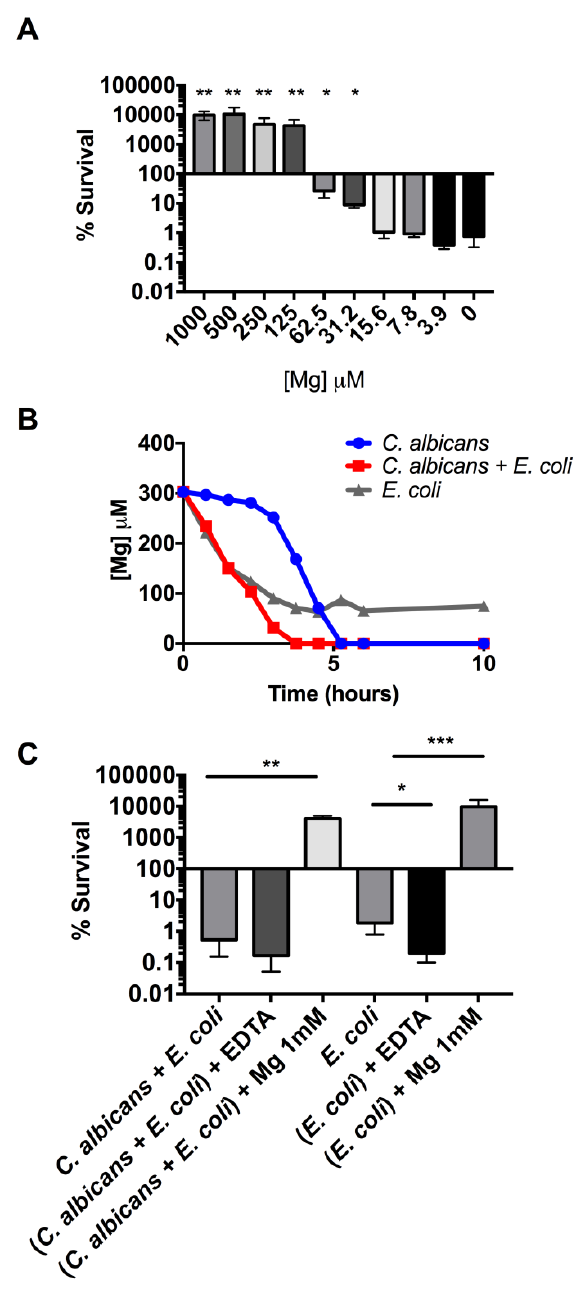
FIGURE 3: E. coli toxicity depends on magnesium